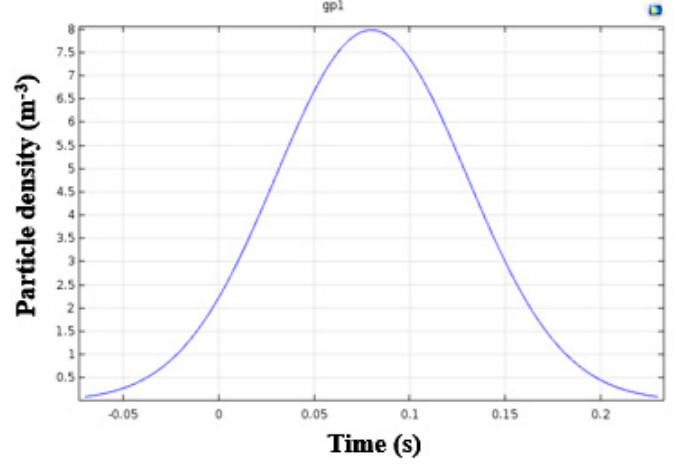
Figure 3. Gaussian impulse function.